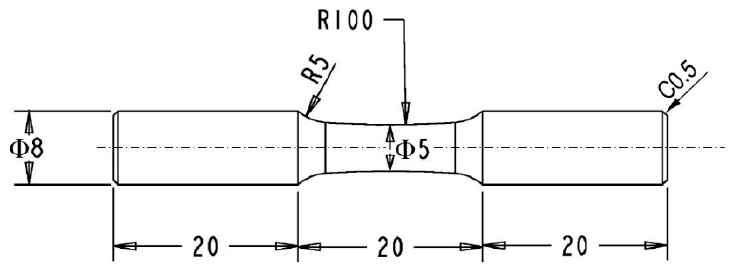
Figure 1. Specimen dimension in rotating bending fatigue testing.